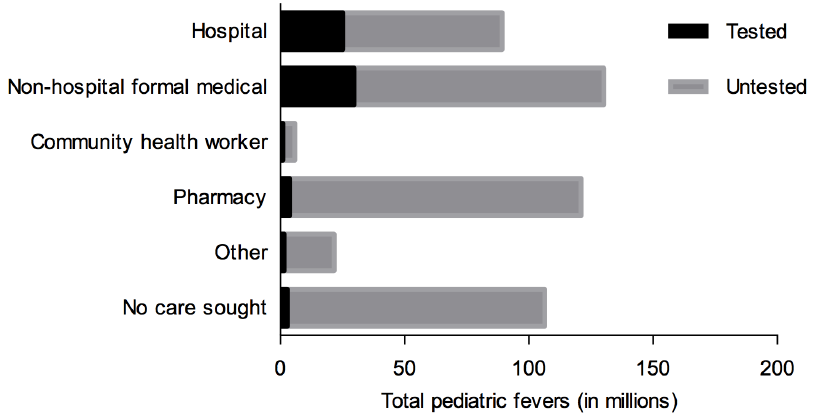
Figure 3. Estimated pediatric fevers attending and tested by source of care in 13 countries in 2010. Figure legend: All totals are given in ‘000 s.